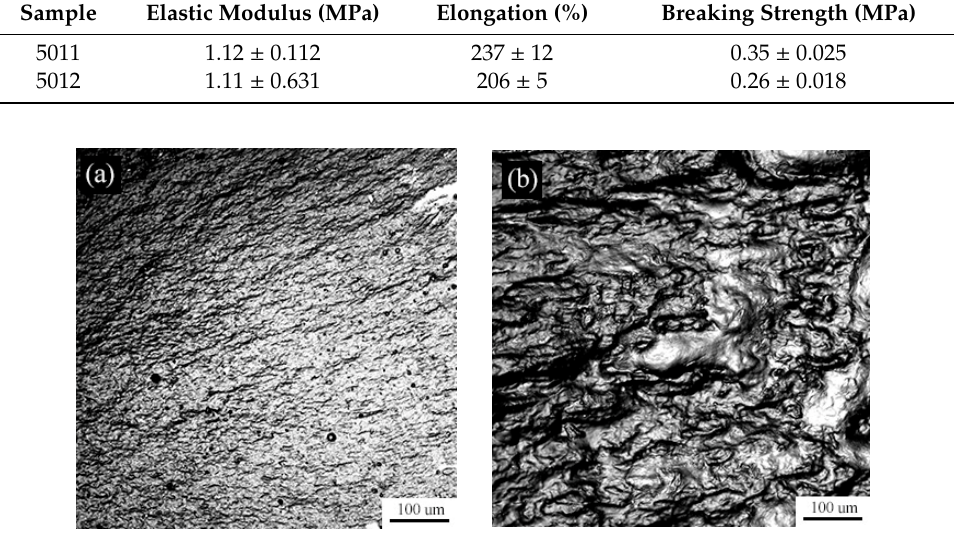
Figure 8. Fracture morphology of coatings ( a ) coating 5011 ( b ) coating 5012.